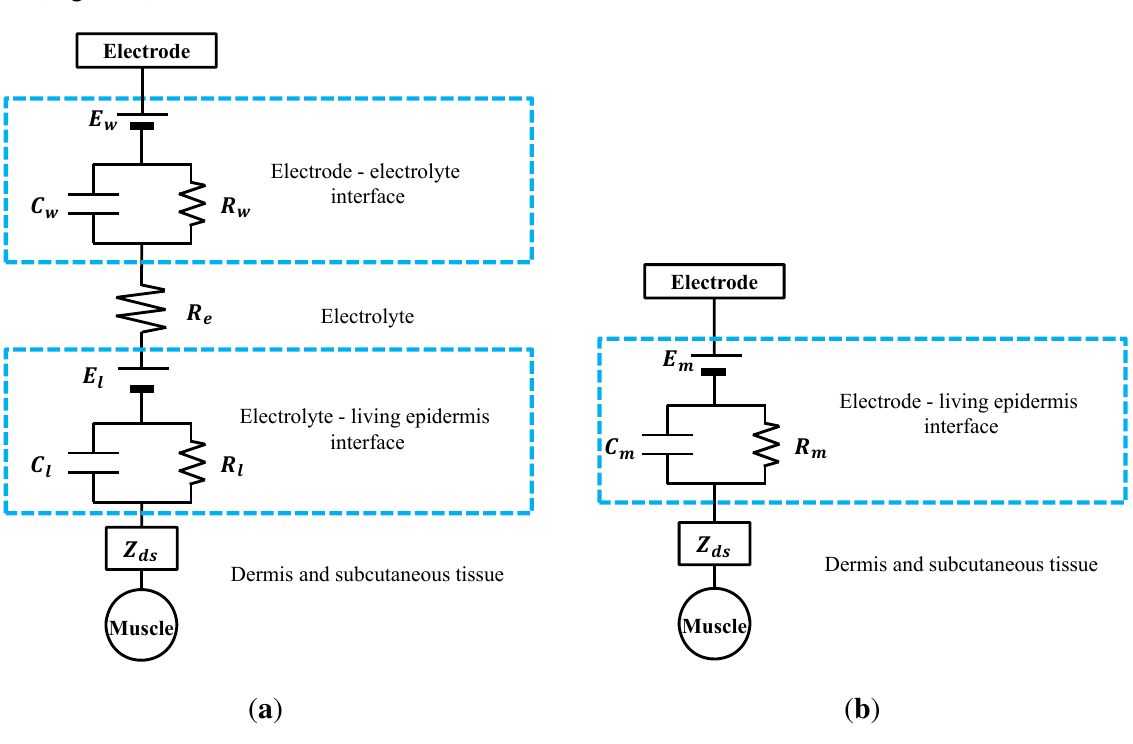
Figure 2. Electrical equivalent circuit models of the standard wet and MNA electrodes. ( a ) Wet electrode model; ( b ) MNA electrode